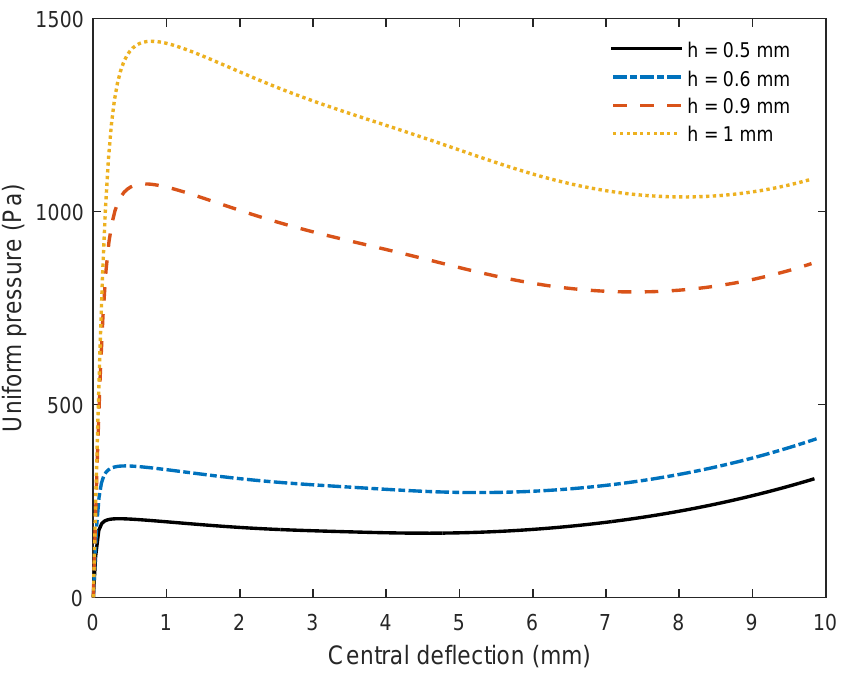
Figure 13. Effect of thickness on nonlinear response of the fully clamped FG-CNTRC cylindrical = 0.11, UD distribution. membrane with κ = 0.2, V ∗ CNT